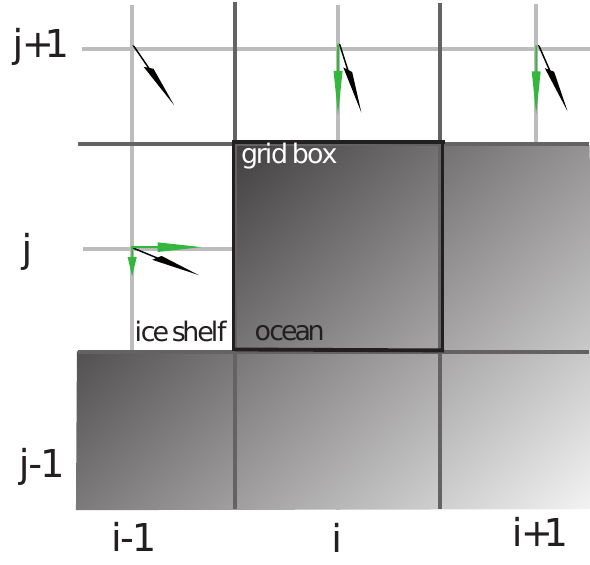
Fig. 3. A bird’s eye view of the ice shelf calving front approximated by a rectangular mesh grid. Gray shaded area denotes ice-free ocean, the ice shelf area is white with exemplary velocity vectors defined on the regular grid. Velocity components directed to the open ocean are shown in green.